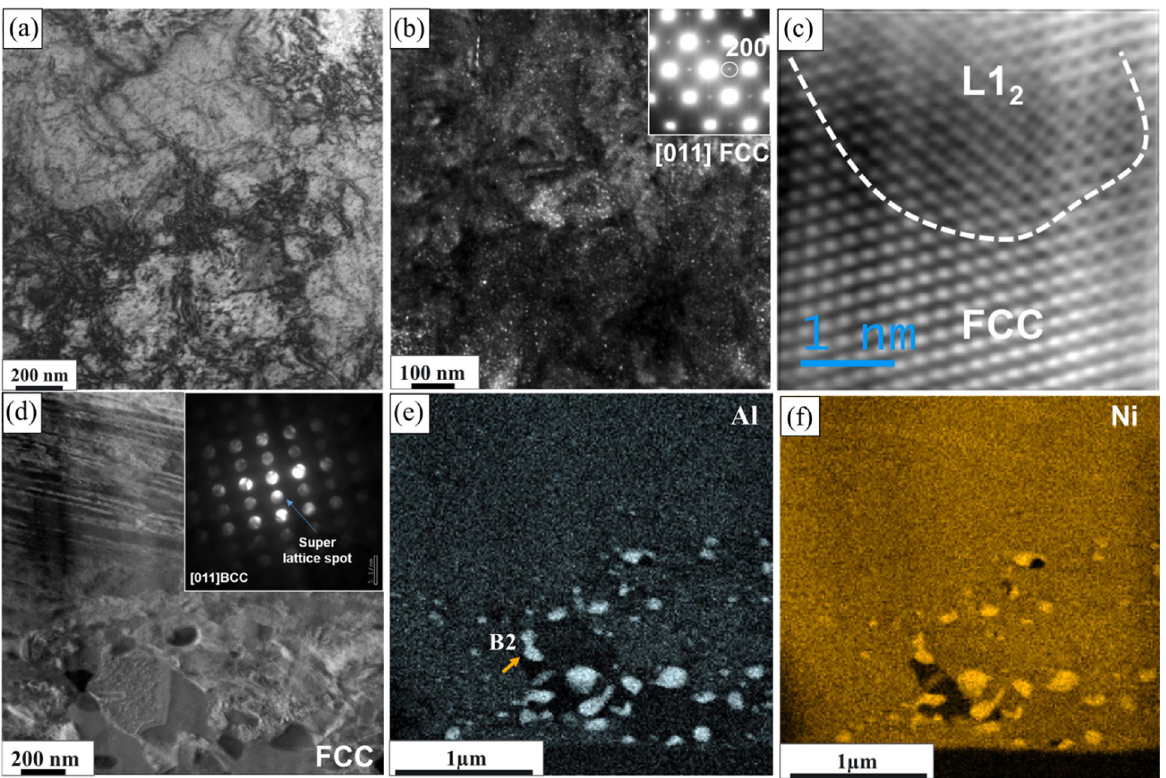
field TEM image with the inset showing TEM SADP recorded from [011] fcc zone axis indicating L1 2 ordering in the matrix; ( c ) HRTEM image showing continuity across the ordered and disordered FCC phases; ( d ) BF-TEM image taken from near the grain boundary showing precipitates and the SADP (inset) confirming the structure of the precipitates to be ordered B2; ( e ) and ( f ) TEM EDS from the grain boundary region confirming (Al, Ni)- rich B2